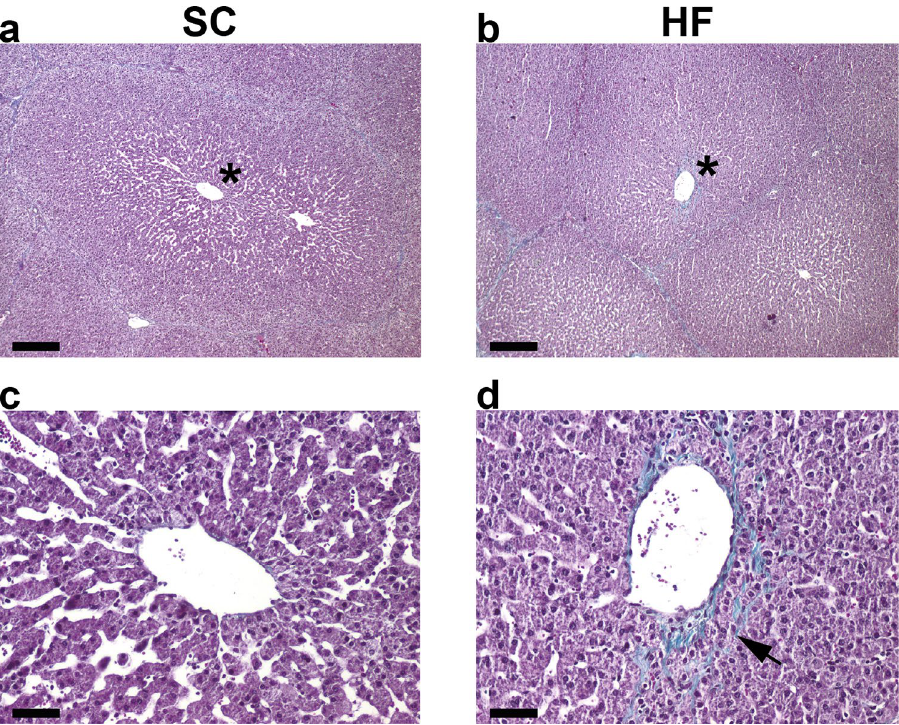
Figure 4. Representative liver Masson’s Trichrome staining of interlobular connective tissue in SC ( a ) and HF ( b ) pigs. An example of grade 1 perisinusoidal zone 3 fibrosis is depicted in a HF pig (arrow head, d ) although grade 0 was more frequently observed in HF pigs. A normal central vein graded 0 is depicted for a SC pig ( c ). Areas in ( a ) and ( b ) (*) are magnified in c and d, respectively. Scalebars 200 µm ( a , b ) and 40 µm ( c , d